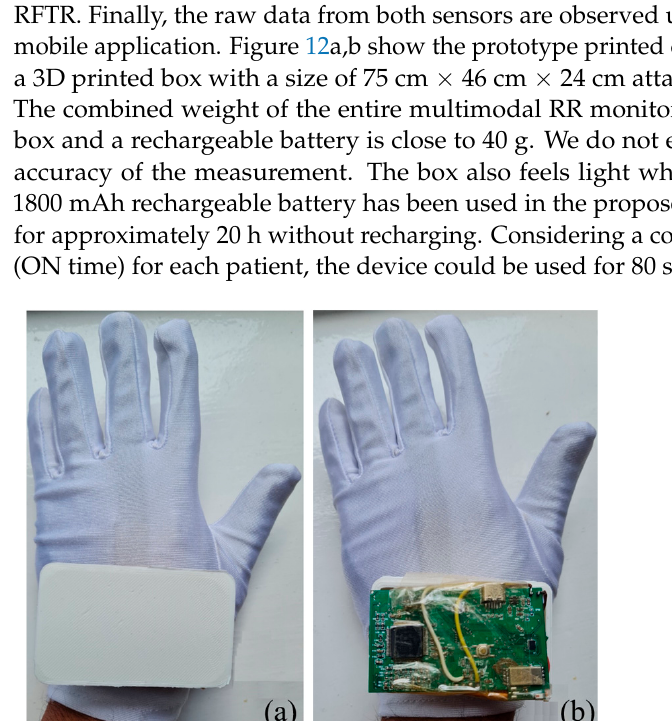
Figure 12. Fabricated RR monitoring system with the textile electrode glove. ( a ) System packaged into a 3D-printed case a tt ached to the gloves. ( b ) The exposed PCB.